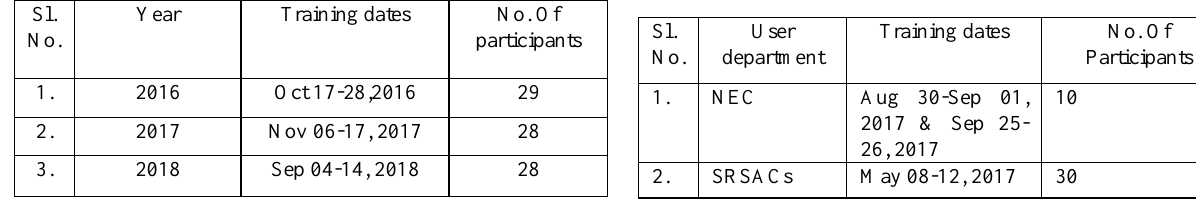
Table 2: User specific UAV trainings at